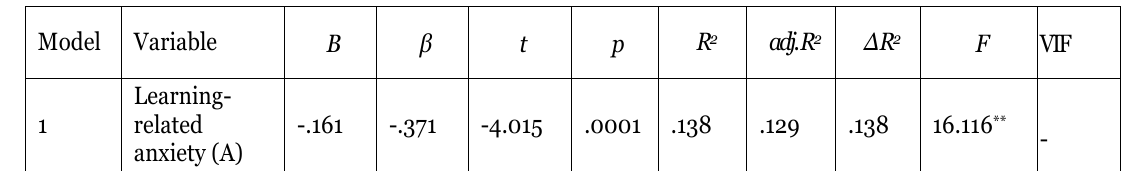
A Test of Buffering Effect of Interaction with Contents on the Relationship of Learning-Related Anxiety and Intention to Persist.